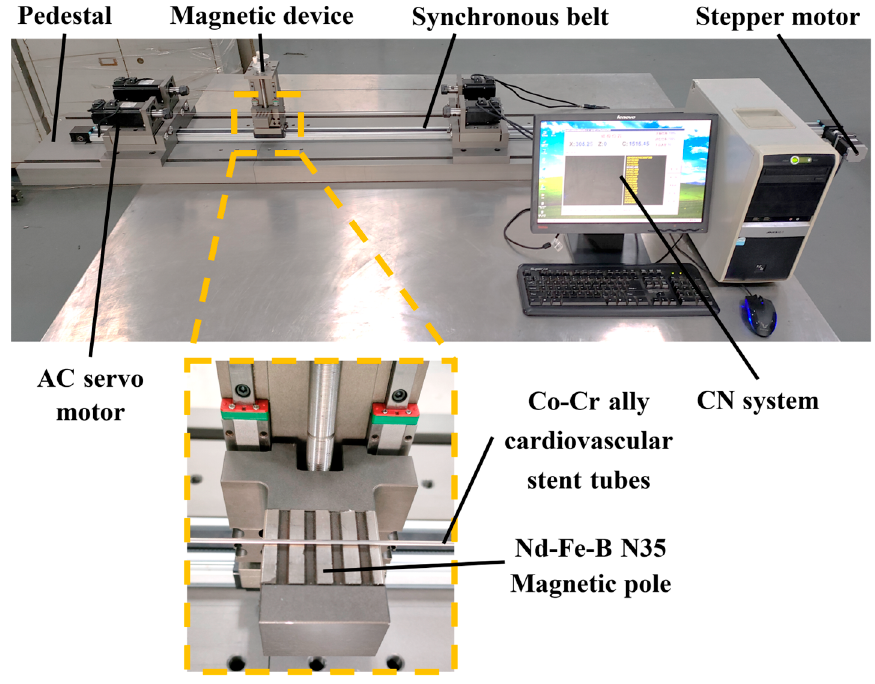
Figure 4. Ultra-slender cardiovascular stent tube inner wall magnetic particle finishing machine.